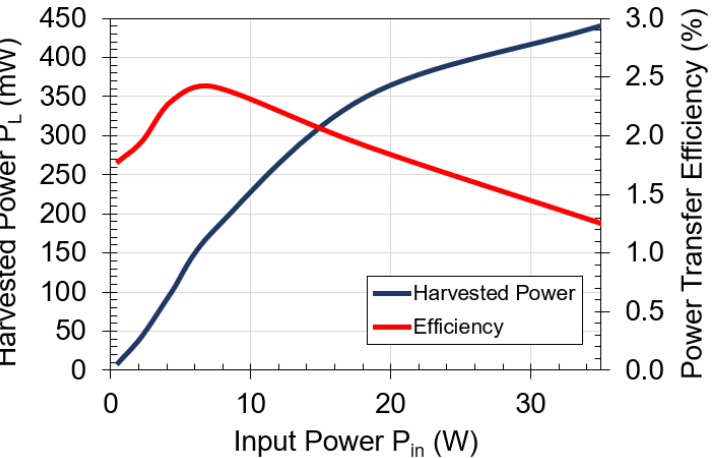
Figure 7. Measured harvested power and power transfer efficiency versus input power for the designed coil with 1 mm-thick aluminum plate in between. Operating frequency is 2 kHz.